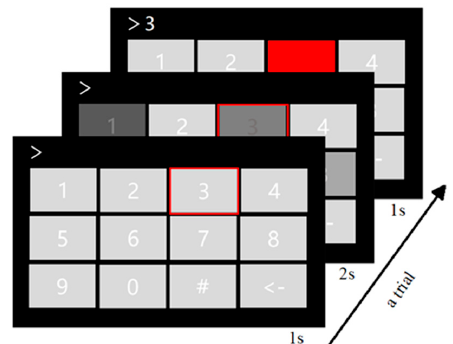
Figure 3. The timeline of a trial in the steady-state visual evoked potential (SSVEP)-based brain–computer interface (BCI) experiment, including visual cues with a red frame for 1 s, stimulus with a red frame for 2 s, and feedback with a red box for 1 s.